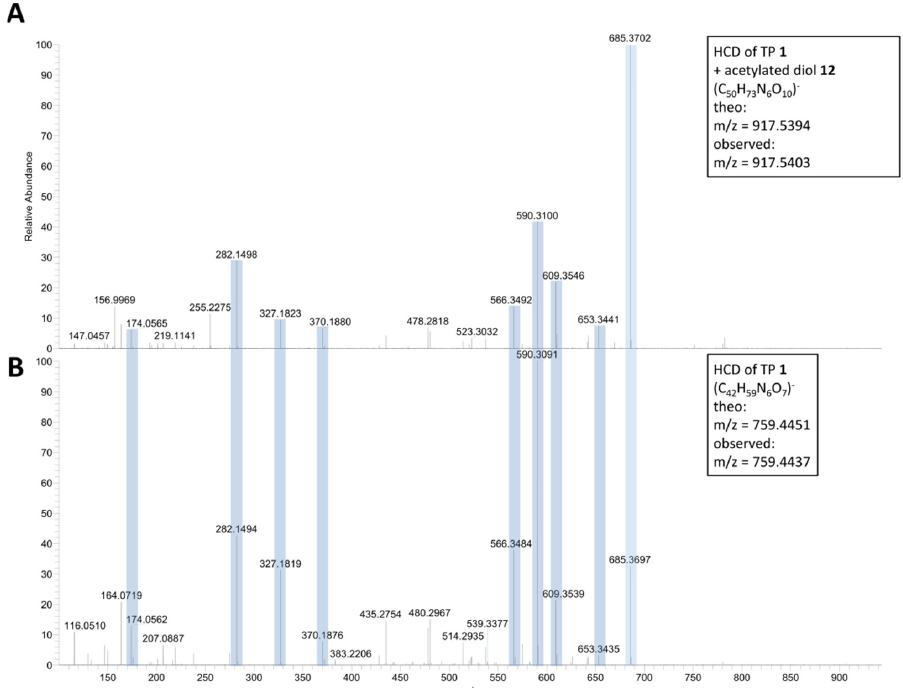
Figure 3. HCD of the reaction product complex with m/z = 917.53 ( A ) and HCD of 1 m/z = 759.44 ( B ) with equivalent fragment masses accentuated by light blue color. Stacked plot of negative ion mode (ESI − ) spectra of tetrapeptide 1 with acetic anhydride 3 as well as R , R − trans − cyclohexane − 1,2 − diol ( R , R ) -2 ( A ) and 1 alone ( B ), sprayed from DCM. The obtained HRMS fragment masses can be assigned to tetrapeptide 1 as their parent structure (the fragments observed were the same as in toluene for the acetate adduct of 1 with m/z = 819.4667 (See supporting information Figure S5)). This shows that the detected ions of the complex with m/z = 917.5394 contained tetrapeptide 1 . To further analyze the reaction product complex HCD dissociation curves of the complex at m/z = 917.53 as well as the adduct complex of tetrapeptide 1 and acetic acid 15 were acquired to allow a relative comparison of their stability (Figure 4).